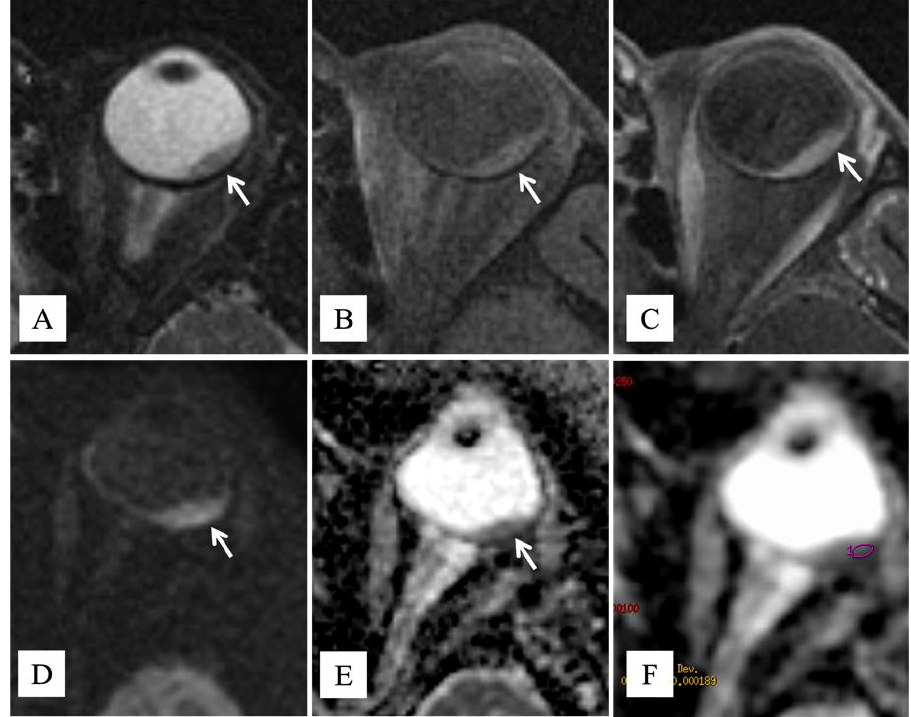
Figure 1. MR findings. Axial ( A ) T2-weighted turbo spin-echo STIR and ( B ) fat-suppressed T1-weighted images show a lentiform-shaped intraocular mass along the postero-lateral aspect of the left globe (white arrows), adjoining the optic disk. The lesion exhibits intermediate signal intensity on both T1- and T2-weighted images, a finding consistent with poorly pigmented melanoma. On ( C ) axial contrast-enhanced fat-suppressed T1-weighted image, the neoplasm demonstrates marked enhancement (white arrow). On ( D ) axial DW image (b = 1000 s/mm 2 ) and ( E ) corresponding ADC map, the tumor displays restricted diffusion with high signal intensity on DWI image and low signal intensity on ADC map (white arrows), a finding consistent with hypercellularity. ( F ) The ADC value was 840 × 10 − 6 mm 2 /s.